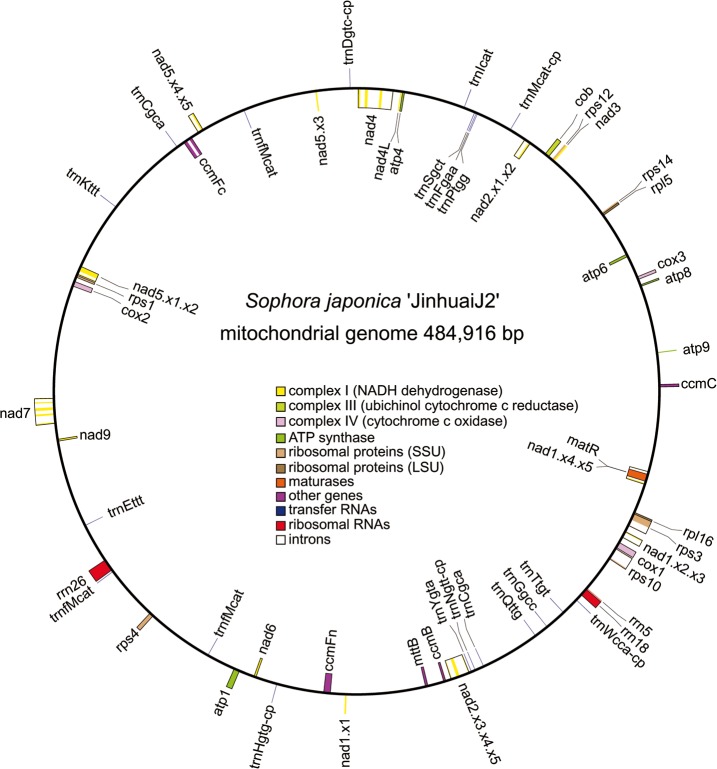
Mitochondrial genome map of the master circle configuration of Sophora japonica ‘JinhuaiJ2’.Genes (exons are closed boxes) shown on the outside of the circle are transcribed clockwise, whereas those on the inside are transcribed counter-clockwise. Genes from the same protein complex are colored the same, introns are indicated in white boxes, and tRNAs of chloroplast origin are noted with a ‘-cp’ suffix.